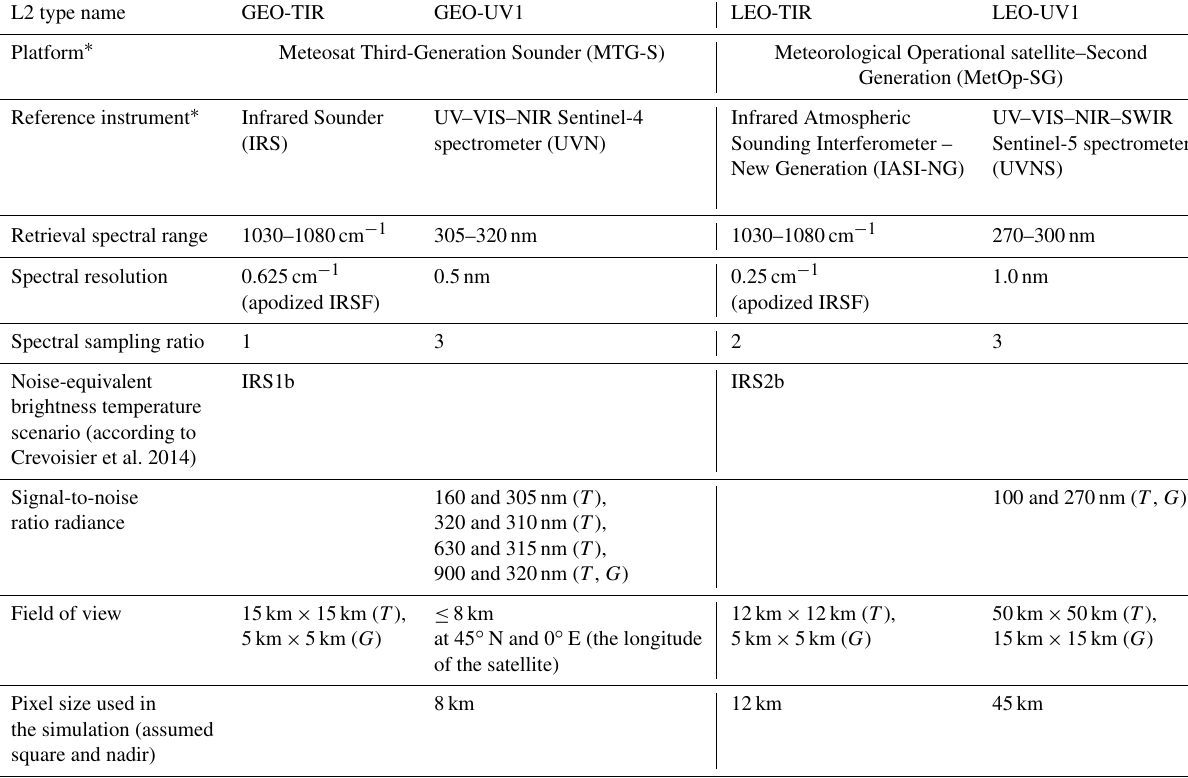
Table 1. Instrument characterization relevant for the simulation process. Goal ( G ) and threshold ( T ) values correspond, respectively, to estimates of the parameters in the case that the instrument performs at its best and to limit values that we expect to reach anyhow. AURORA will be using threshold values for the generation of simulated